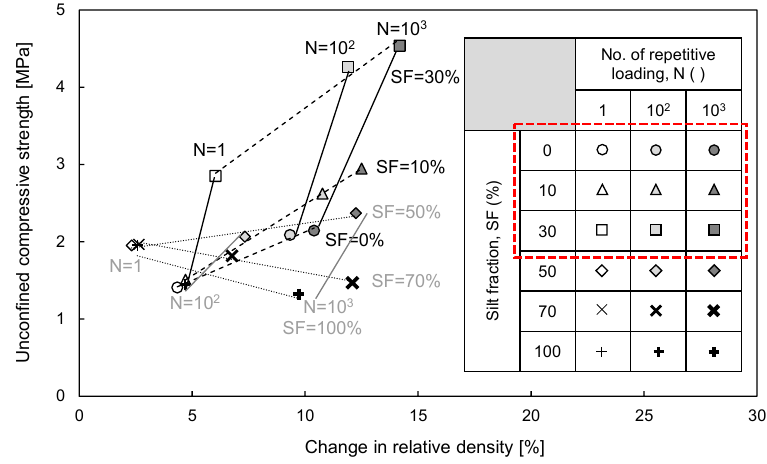
Figure 13. Relationship between unconfined compressive strength and change in relative density of sand–silt mixtures.